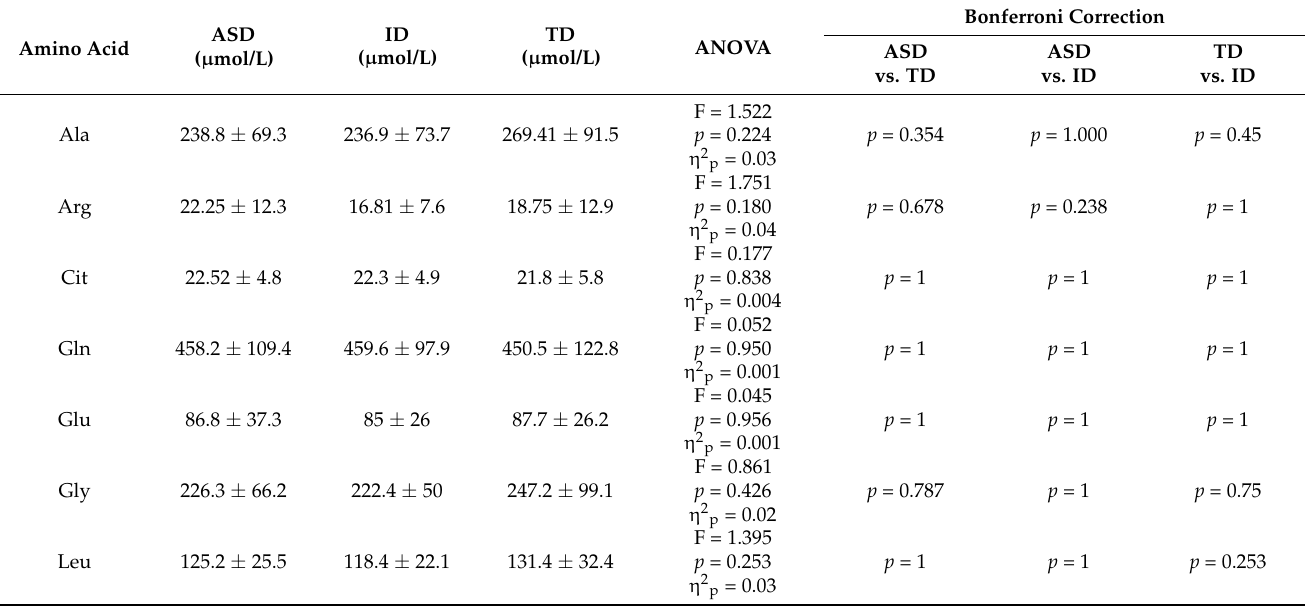
Table 1. Amino acid levels comparison with ANOVA test in the three studied groups and paired post hoc comparisons with Bonferroni pairwise